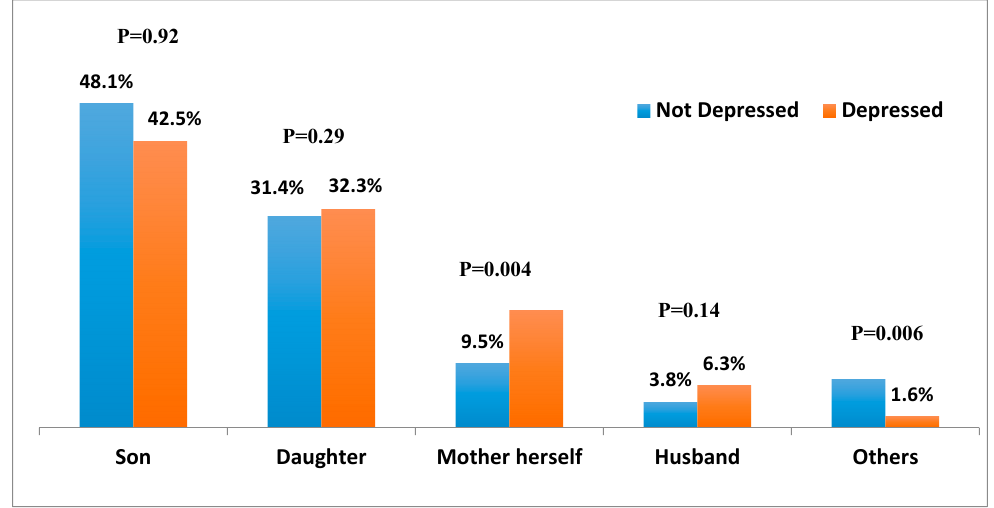
Figure 1. Distribution of illness in the family members (mother herself or offspring or husband or anyone else) in the last one month by depression status ( n = 464).